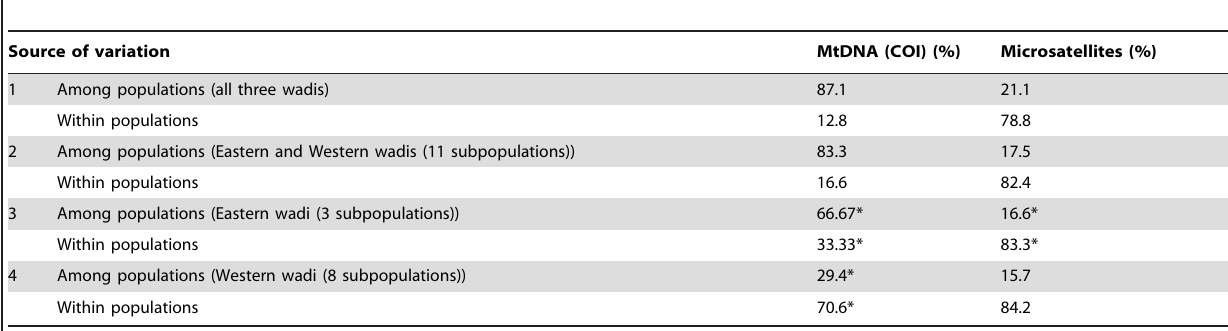
Table 4. Results of comparative hierarchical AMOVAs for four different populations structures analyzed for mitochondrial and microsatellite data.